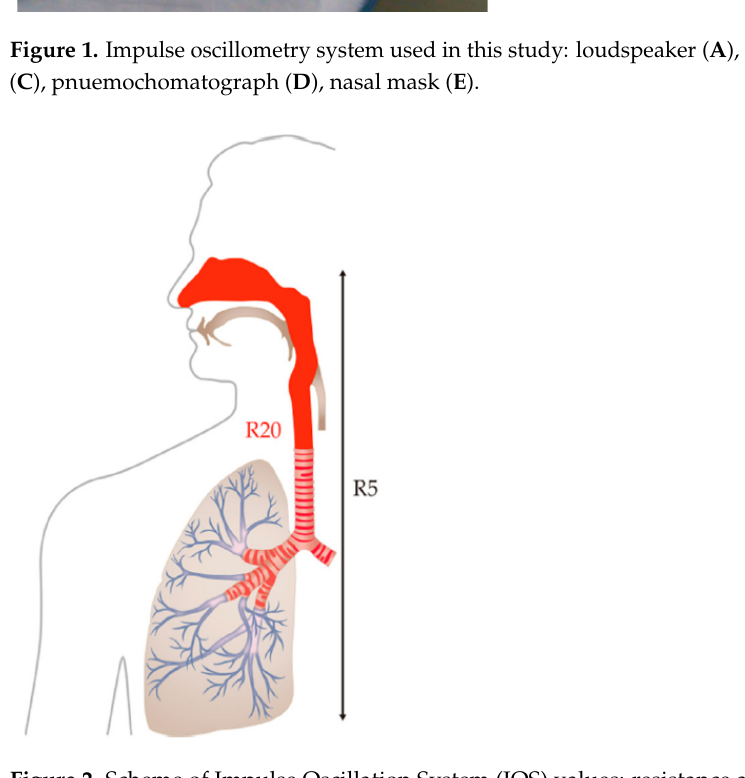
Figure 2. Scheme of Impulse Oscillation System (IOS) values: resistance at 5 Hz (R5); resistance at 20 Hz (R20). R5 and R20 represent the total airway resistance and the resistance of the region from the upper airway through to the central airway,